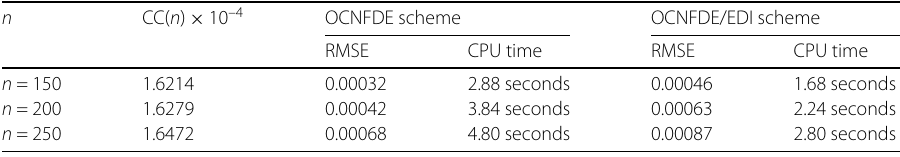
Table 2 Comparisons of CC, RMSE, and CPU time of the OCNFDE and OCNFDE/EDI solutions n CC( n ) × 10 –4 OCNFDE scheme OCNFDE/EDI scheme RMSE CPU time RMSE CPU time n = 150 1.6214 0.00032 2.88 seconds 0.00046 1.68 seconds n = 200 1.6279 0.00042 3.84 seconds 0.00063 2.24 seconds n = 250 1.6472 0.00068 4.80 seconds 0.00087 2.80